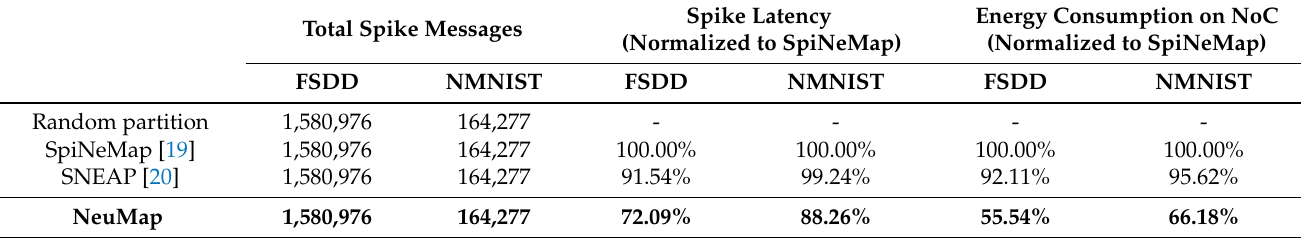
Table 2. The comparison for two LSM